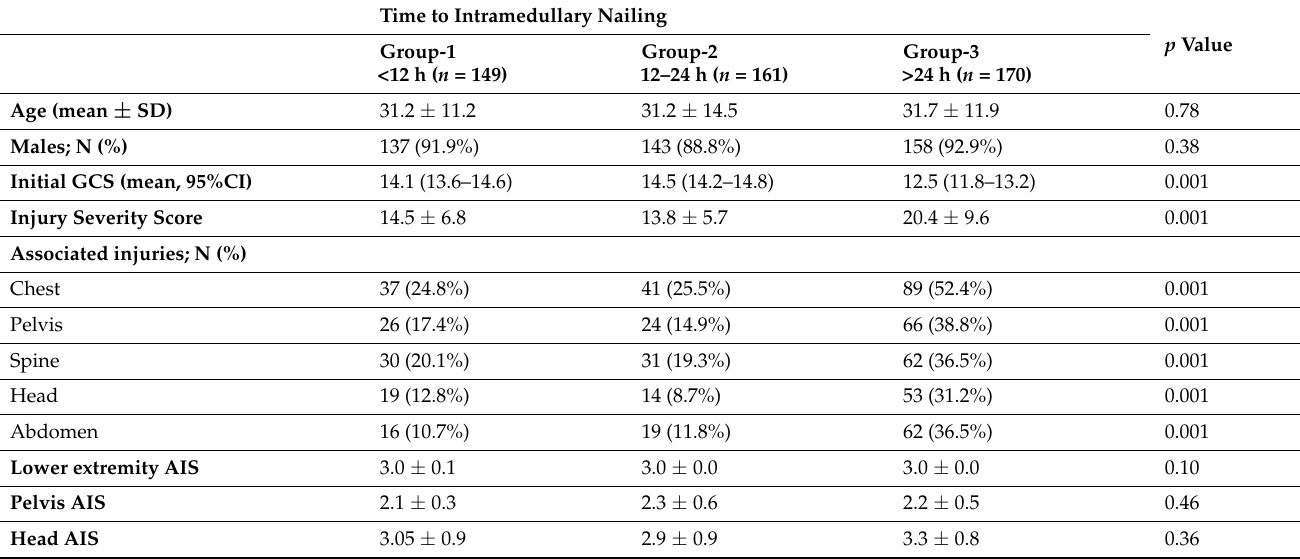
Table 3. Management, complications and outcome by timing of intramedullary nailing ( n =